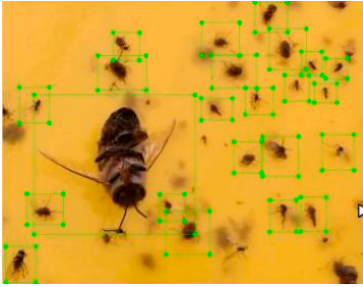
Figure 6. Labeling of flying insects.